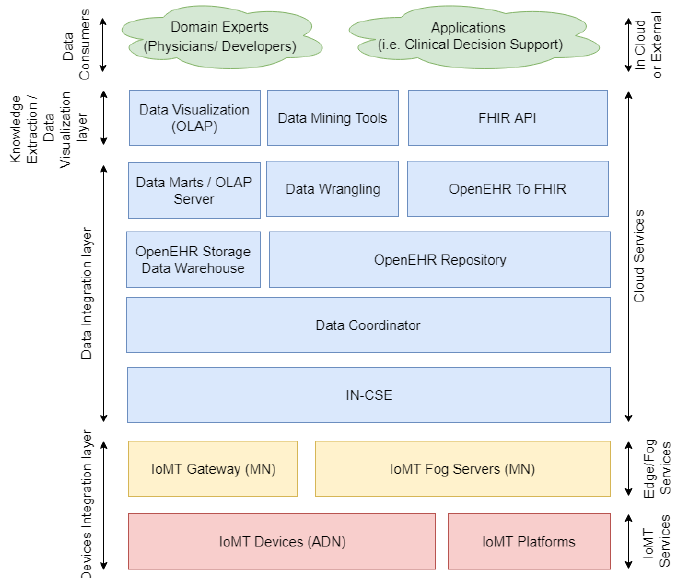
Figure 4. Platform